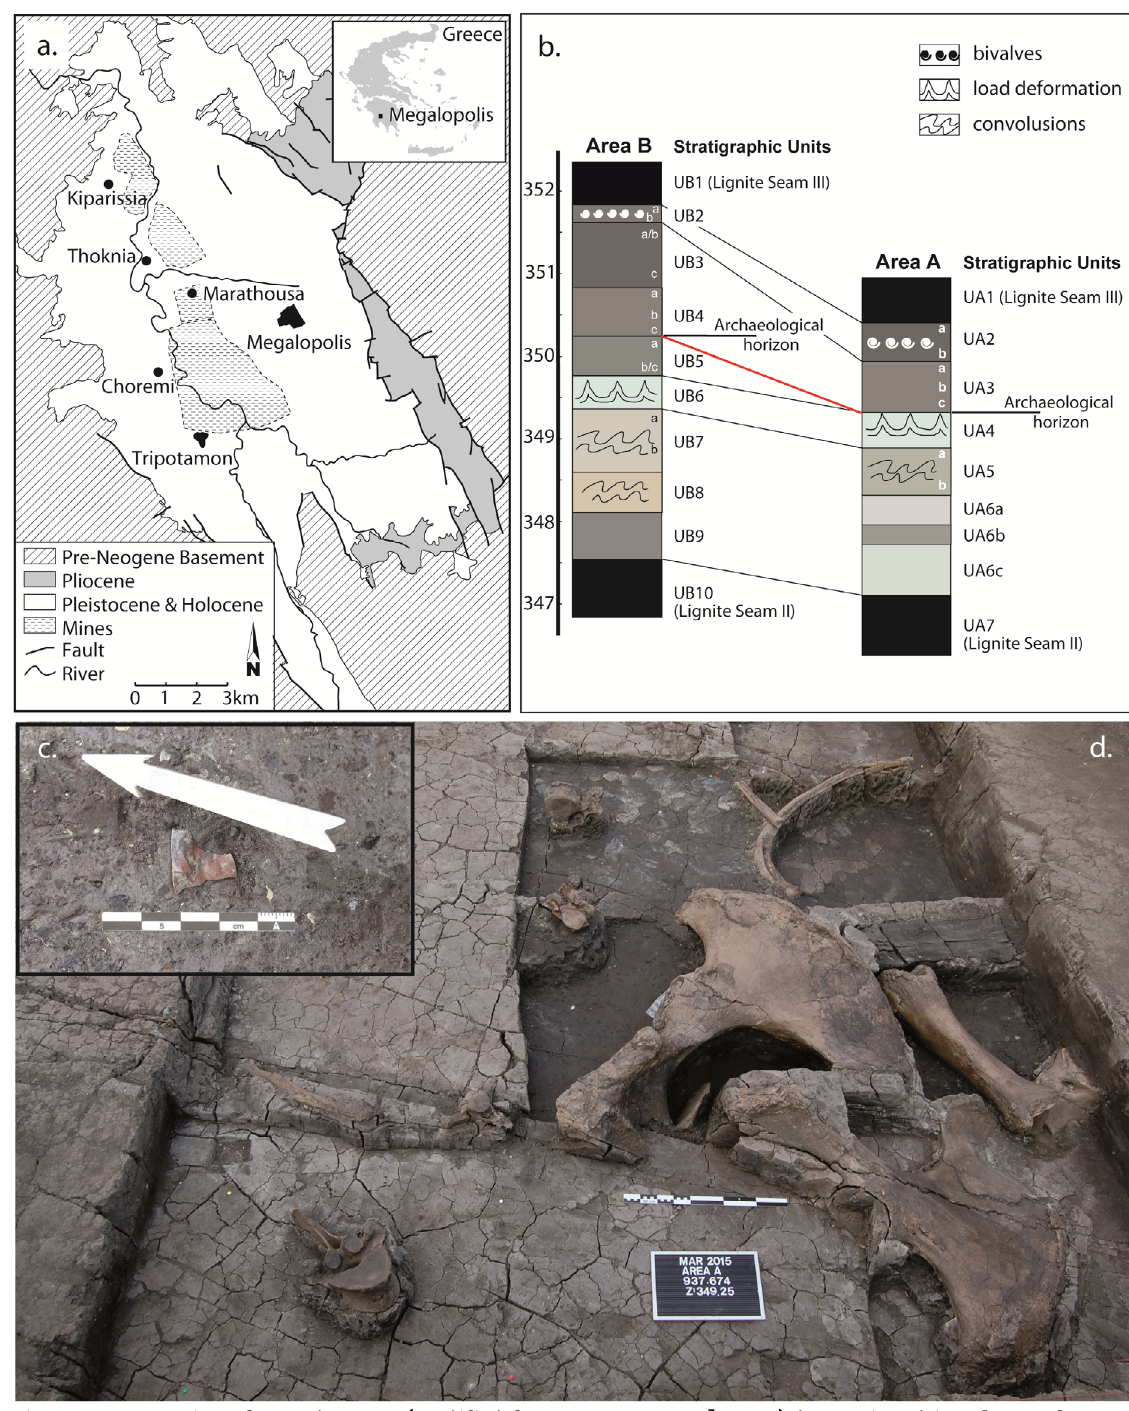
Figure 1. a. Location of Marathousa 1 (modified from van Vugt et al . 2000), b. stratigraphic column of Area A and B, Marathousa 1 (modified from Karkanas et al. 2018), c. Radiolarite flake recovered from the mudflow of UB4c, d. panoramic view of Area A during 2015 field campaign, showing the distribution of the elephant remains. The tibia to the right of the pelvis bears cut-marks (Konidaris et al.